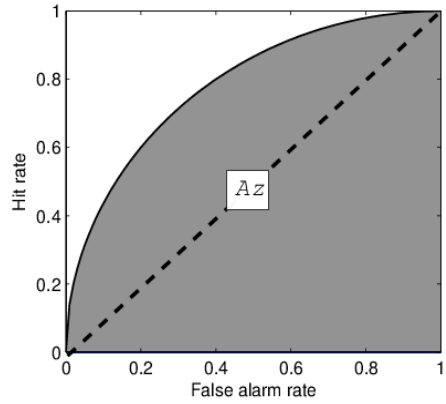
Figure 12. Schematic diagram of Area Under ROC Curve (AUC). The surface of the area is the Receiver Operating Characteristic curve and the area of the shadow is AUC.